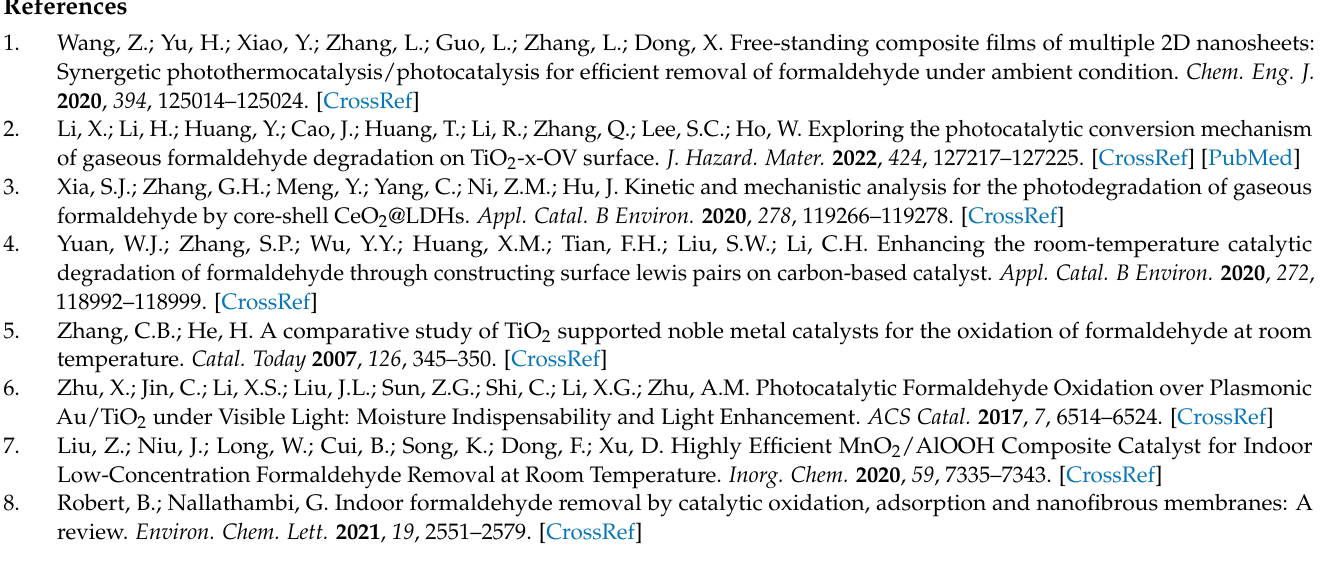
DRIFTS measurements; Figure S2: Schematic diagram of formaldehyde degradation device; Figure S3: SEM image of pristine TiO 2 nanoparticles; Figure S4. HRTEM image of C 60 -EDA/TiO 2 compos- ites; Figure S5: N1s XPS spectra of C 60 -EDA and C 60 -EDA/TiO 2 composite; Figure S6: Catalytic performance of pristine TiO 2 nanoparticles for photodegradation of HCHO under simulated sunlight irradiation; Figure S7: Catalytic performance of C 60 -EDA/TiO 2 for photodegradation of HCHO under simulated sunlight irradiation. Formaldehyde concentration and CO 2 evolution amount with increasing photocatalytic time (Initial HCHO concentration at 100 ppm); Figure S8: Catalytic perfor- mance of the C 60 -EDA/TiO 2 with different ratios of C 60 -EDA for photodegradation of HCHO under simulated sunlight irradiation; Figure S9: SEM images of the C 60 -EDA/TiO 2 sample before and after 12 cycles of the photocatalytic reactions; Figure S10: XRD spectra of C 60 -EDA/TiO 2 before and after 12 cycles of the photocatalytic reactions; Figure S11: EPR spectra in (a) methanol dispersion system and (b) deionized water dispersion system; Figure S12: In situ DRIFT spectra of TiO 2 (a) before and (b) after illumination; C 60 -EDA/TiO 2 (c) before and (d) after illumination; Table S1: Comparisons of the catalytic performances between C 60 -EDA/TiO 2 and other reported formaldehyde catalysts; Figure S13. The molecular structures of the fullerene derivatives (a) C 60 -EDA and (b) C 60 -COOH; Figure S14. The XRD of TiO 2 and C 60 -EDA/TiO 2 with comparison with standard PDF card of anatase titanium dioxide; Figure S15. Catalytic performance without photocatalyst and with C 60 -EDA; Figure S16. Band gap energy diagram of (a) C 60 -EDA and (b) C 60 -COOH; Figure S17. XRD spectra of the C 60 -EDA/TiO 2 with different ratios of C 60